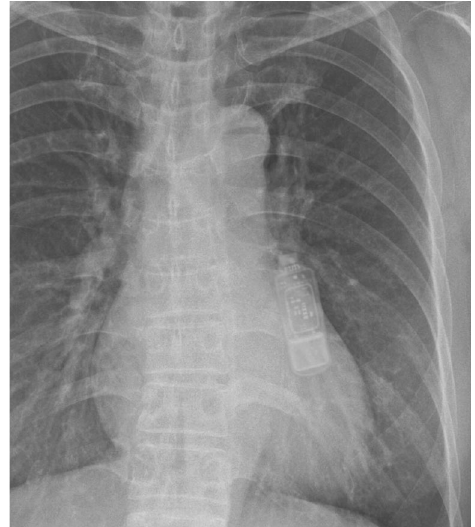
Fig. 14 A single-lead right-sided pacemaker is present. There is also an abandoned left-sided lead without the pulse generator